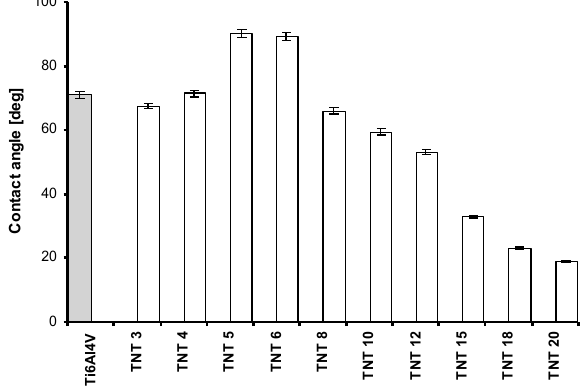
Figure 2. Results of wettability studies of TNT3-TNT20 samples.